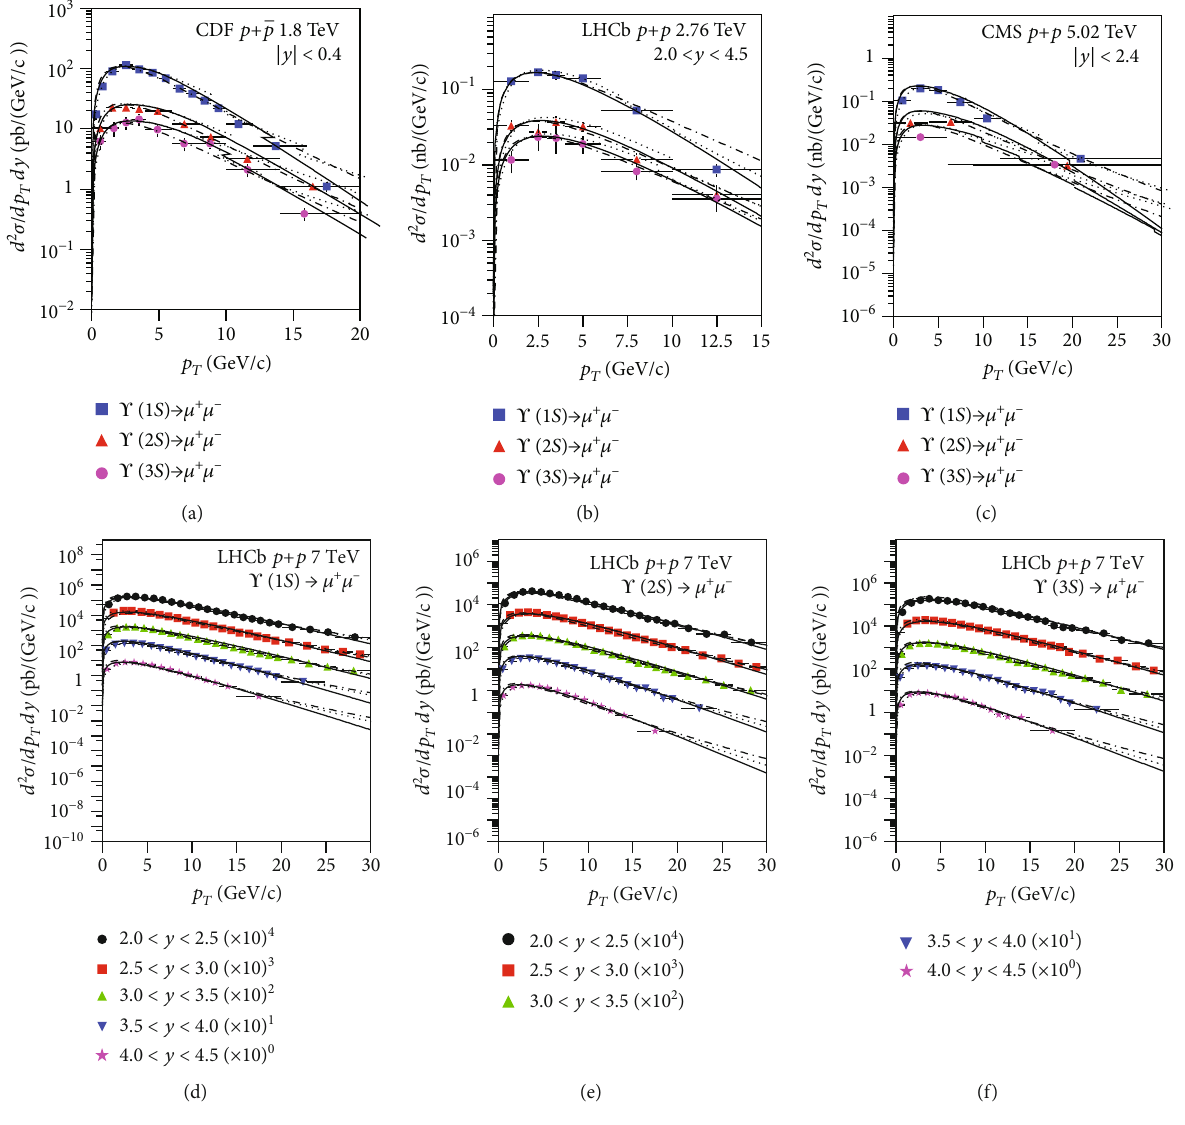
dy and (b) d σ / dp – c) Y ð nS , n = 1, 2, 3 Þ ⟶ μ + μ − , (d) Y ð 1 S Þ ⟶ μ + μ − , (e) Figure 5: Transverse momentum spectra, (a, c – f) d 2 σ / dp T T , of (a Y ð 2 S Þ ⟶ μ + μ − , and (f) Y ð 3 S Þ ⟶ μ + μ − in (a) p + (cid:1) p and (b – f) p + p collisions at (a) 1.8, (b) 2.76, (c) 5.02, and (d – f) 7TeV. The symbols shown in (a – c) represent the experimental data measured by the (a) CDF [17], (b) LHCb [24], and (c) CMS Collaborations [34] in (a) p + (cid:1) p and (b, c) p + p collisions in (a) ∣ y ∣ <0 : 4 , (b) 2 : 0 < y < 4 : 5 , and (c) ∣ y ∣ <2 : 4 , respectively. The symbols shown in panels (d – f) represent the experimental data measured by the LHCb Collaboration [25] in p + p collisions in 2 : 0 < y < 2 : 5 , 2 : 5 < y < 3 : 0 , 3 : 0 < y < 3 : 5 , 3 : 5 < y < 4 : 0 , and 4 : 0 < y < 4 : 5 and scaled by di ff erent amounts shown in the panels. The data points are fi tted by the Erlang distribution (Eq. (3)), the Hagedorn function (Eq. (4)), and the Tsallis-Levy function (Eq. (6)) by the solid, dashed, and dotted curves,